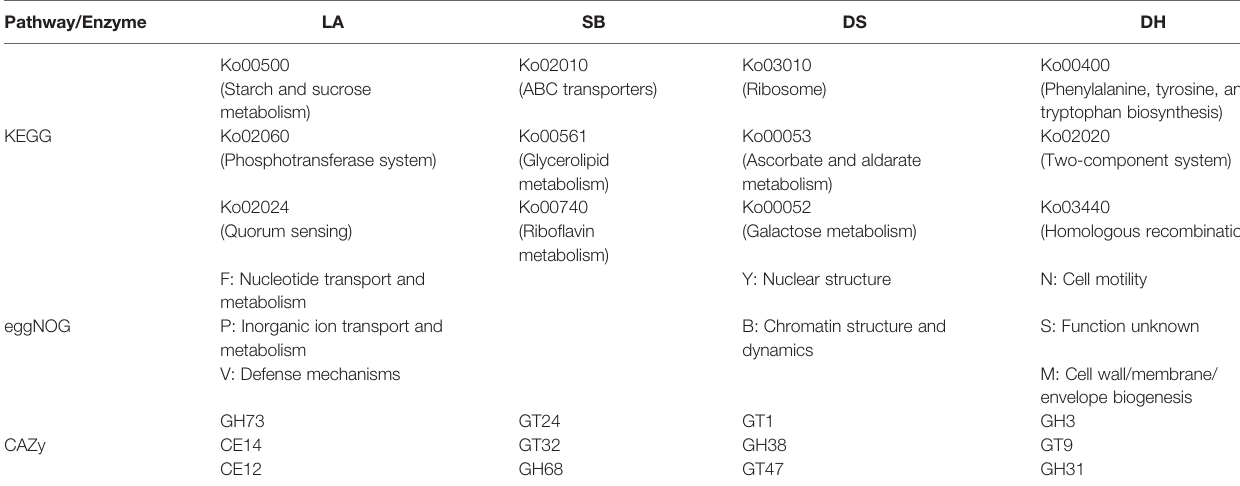
TABLE 2 | Top differentially abundant pathways among the four pig